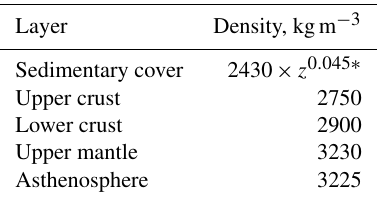
Figure 3. Framework of the studied region with the seismic con- straints on Moho depth. Relief is taken from the ETOPO1 model (Amante and Eakins, 2009). Seismic estimates of depth to Moho are used according to USGS seismic catalogue (Chulick et al., 2013), TATSEIS-2003 (Trofimov, 2006), URSEIS-95 (Puchkov, 2010; Tryggvason et al., 2001), ESRU (Brown et al., 2002; Rybalka et al., 2006), and UWARS profiles (Thouvenot et al., 1995). Table 2. Density model used in the